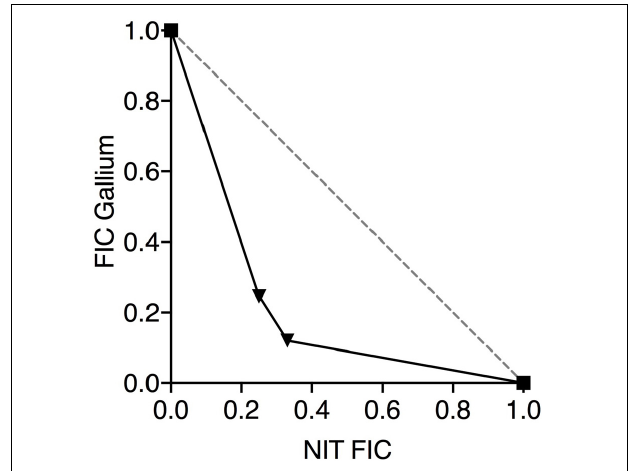
FIGURE 5 | Decreased Ga intake raises MIC but synergy is preserved. Isobolograms show the results of checkerboard assays using PA14 hitA: IS under aerobic conditions. Three replicates